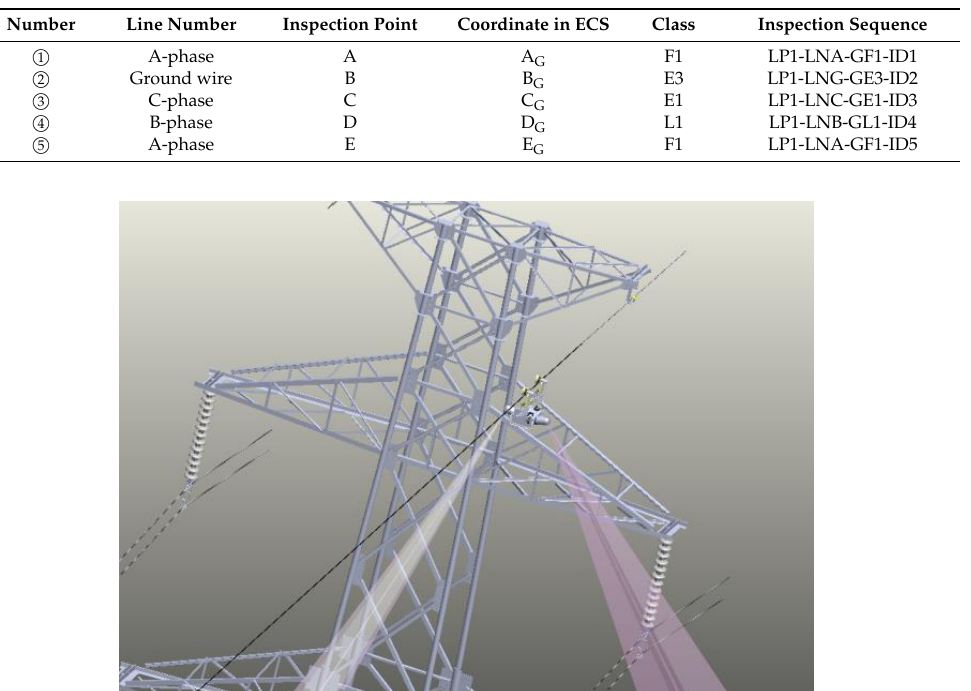
Figure 13. The schematic diagram of the autonomous positioning inspection. Table 3. Inspection sequences of waiting-inspection targets in k th span segment.